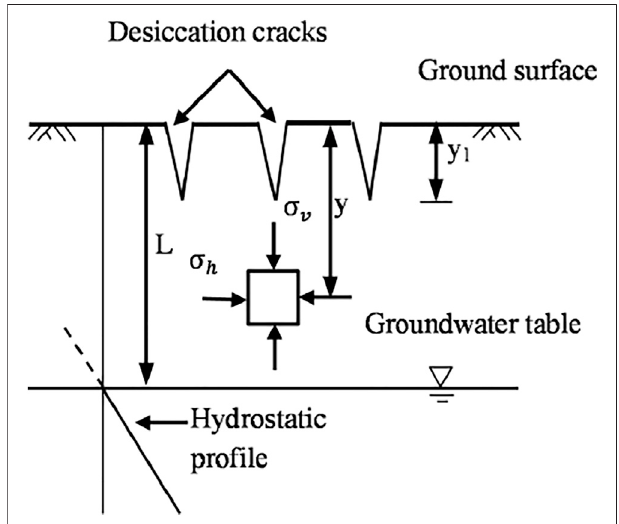
FIGURE 6 | Curves of the peak deviator stress and number of wetting – drying cycles.